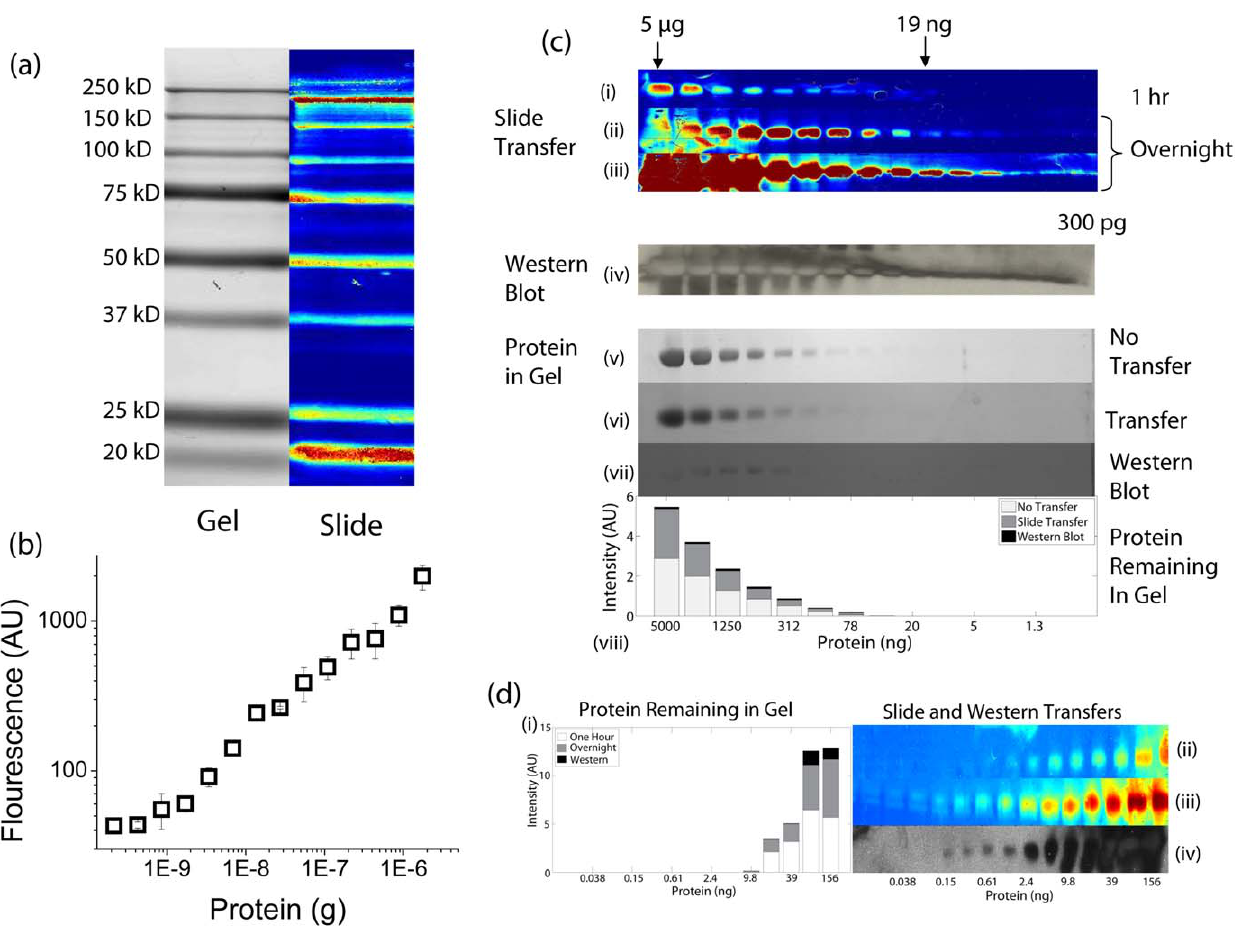
Figure 1. Characterizing Western Transfer Efficiency. (a) Transfer of a protein ladder. A BioRad Blue protein ladder was run on a 10% SDS acrylamide gel and diffusively transferred for one hour to an aminosilane slide. The slide was scanned with the Axon 4000B microarray scanner, and the gel was scanned with the Typhoon fluorescent scanner after transfer. There is a direct spatial correspondence between the protein in the gel and the slide. All molecular weights transfer. It should be noted, that the lower molecular weight proteins diffuse more readily than the higher molecular weight proteins. Therefore, the lower molecular weight proteins will transfer faster, but also diffuse laterally, creating a wider band. As can be seen from the gel scan, the vast majority of the protein remains in the gel. (b) Detection limit of 30 minute transfer with DiG-Stamping. The minimum detection limit was 10 ng of biotin BSA after transferring for 30 minutes. The average of 3 gels with standard deviation is shown. (c) Comparison of Western blot with DiG-Stamping. Serial dilutions of biotin BSA were run on identical SDS gels (10%) and either diffusively transferred for 1 hour (i) or overnight [ii (low gain) and iii (high gain)] to an aminosilane slide, or transferred via Western blot to nitrocellulose (iv). Slides and Western Blot were processed as described in Protocol S1. After 1 hour, 19 ng (i) could be detected on the diffusive blot, and after overnight transfer, 300 pg (iii) could be detected. 300 pg was readily detected using the Western blot (iv). To establish the amount of protein that remains for analysis in the gel after transfer, a gel without transfer was stained with Commassie blue, and scanned (v), providing a reference. After overnight transfer to a slide (vi), almost all of the protein remains in the gel. In the case of the Western blot (vii), very little of the protein remains in the gel after transfer. The quantification of the amount of protein remaining in each gel is shown. (d) Detection limit comparison of Western blotting to DiG-Stamping. To further probe the detection limits, the same experiment as in (b) was repeated, but with smaller amounts of protein. Western blot showed a limited of , 150 pg, and the overnight transfer showed a limit of , 19